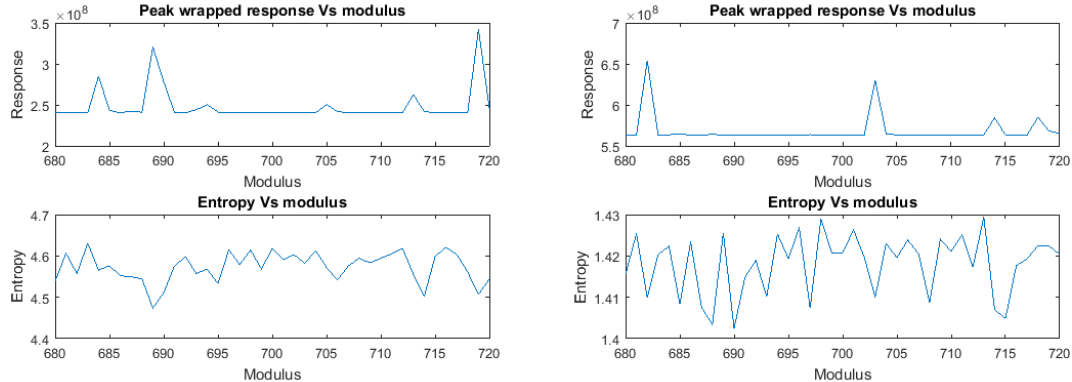
Figure 8. ( a ) Maximal wrapped response along the cardo direction as a function of the modulus; ( b ) Maximal wrapped response along the decumanus direction as a function of the modulus; ( c ) Entropy of the wrapped response along the cardo direction as a function of the module; ( d ) Entropy of the wrapped response along the decumanus direction as a function of the modulus.